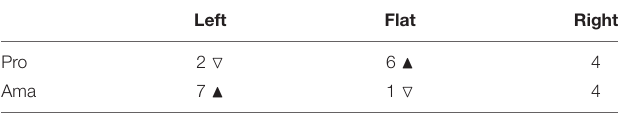
TABLE 1 | Total number of answers on slope perception for the 0-degree condition.